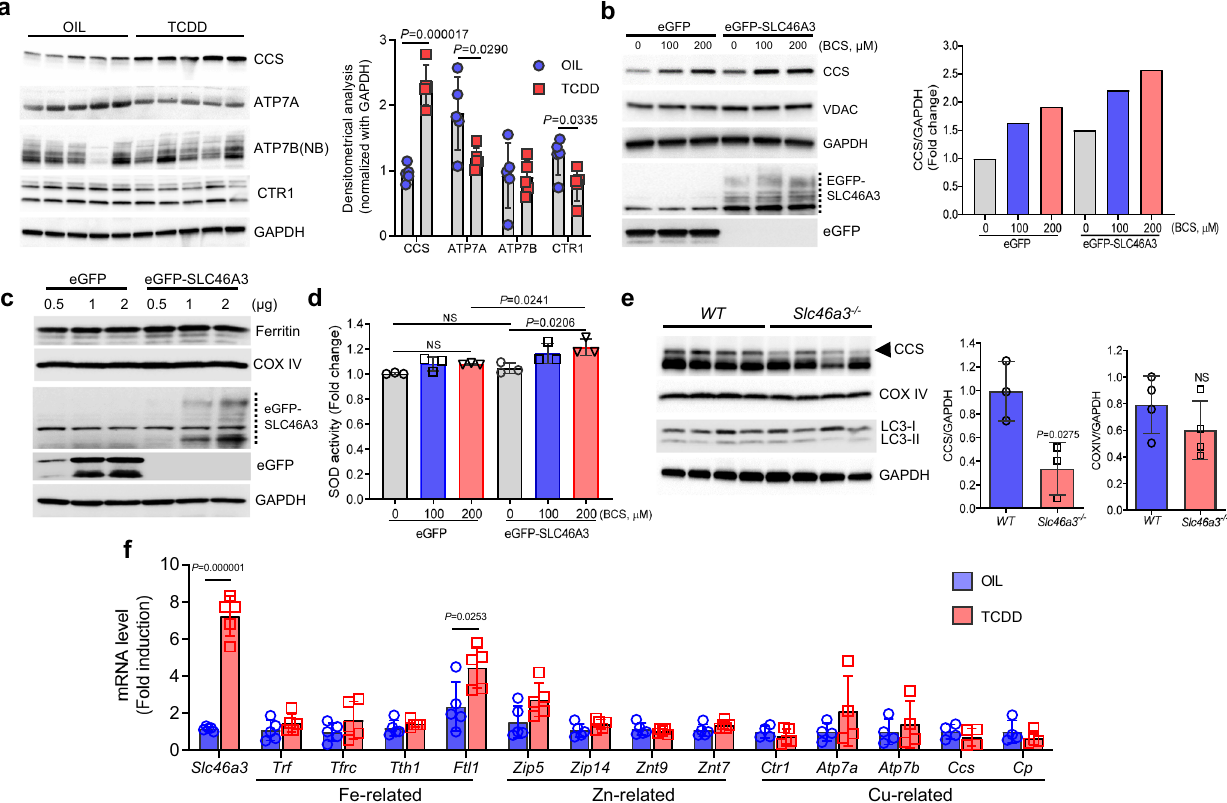
Fig. 4 TCDD and eGFP-SLC46A3 increases the copper chaperone for superoxide dismutase. a Western blotting data show the level of copper-related proteins in the liver after oil ( n = 5 per group) or TCDD (10 μ g/kg for 7 days) treatment ( n = 5 per group). Densitometrical analysis is shown in the right panel. b Western blotting data show the level of copper chaperone for superoxide dismutase (CCS) protein level after treatment with BCS (Cu (I) chelator in the media) for 3 days in the presence of eGFP-SLC46A3 in Hepa1c1c cells. Densitometrical analysis is shown in the right panel. NB nonboiled sample. c The level of heavy chain of ferritin, an indicator of labile cytoplasmic iron levels, was measured after induction of eGFP-SLC46A3 in Hepa1c1c7 cells. d SOD activity was measured when Hepa1c1c7 cells were treated with different doses of BCS in the presence of eGFP-SLC46A3. e Western blotting data show the level of copper chaperone for superoxide dismutase (CCS) in the livers from wild-type (WT)( n = 4 per group) and Slc46a3 − / − mice ( n = 4 per group). Densitometrical analysis is shown in the right panel. f Expression of mRNAs encoding metal transporters in the mice liver after oil ( n = 4 per group) or TCDD (10 µ g/kg for 24 h) ( n = 5 per group) administration. Each data point represents the mean ± SD and adjusted p value, presented in the panels, was determined by unpaired two-tailed Student ’ s t test using indicated sample sizes and revealed two ions [16:0/18:1/18:2] and TG [16:0/18:2/ 18:2] as TG (Supplementary Fig. 4d). Thus, hepatic levels of Acadm, Acox1, Fasn, Acc1, Scd1, Lcat, Cd36, Hsl, Pnpla2, Aadac, Tgh, Mttp, Dgat1, Dgat2, Fsp27 , and Plin2 mRNAs encoding TG/NEFA-related pro- teins were measured. However, no difference between WT and Slc46a3 − / − in their expression levels was found under the condition of both vehicle and TCDD treatment (Fig. 6h).